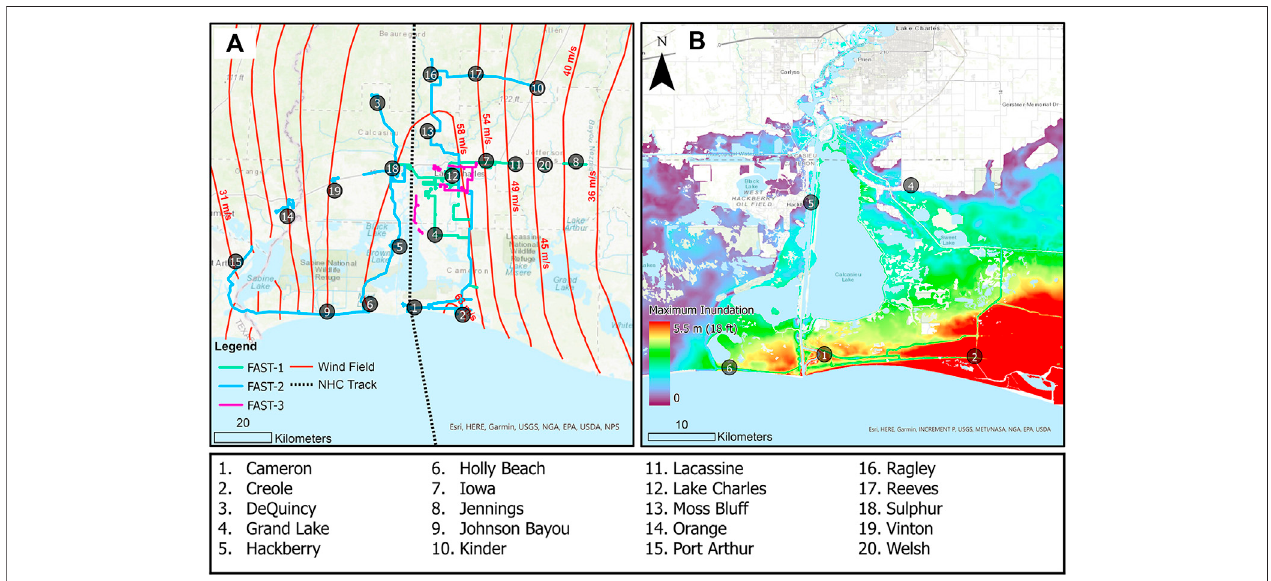
FIGURE 8 | Visual summary of surveyed communities relative to ( A ) preliminary Hurricane Laura track from the National Hurricane Center (NHC) and standardized gust wind speed estimates (red contours showing 3-second averaging time, 10 ° m height, open exposure) from Applied Research Associates (Version 3 wind fi eld), includingFASTstreet-levelpanoramaroutes(coloredblue,greenandfuchsialines);and( B )coloredheatmapofmaximuminundationdepthabovegroundfromADCIRC hindcast (NHC best Track).